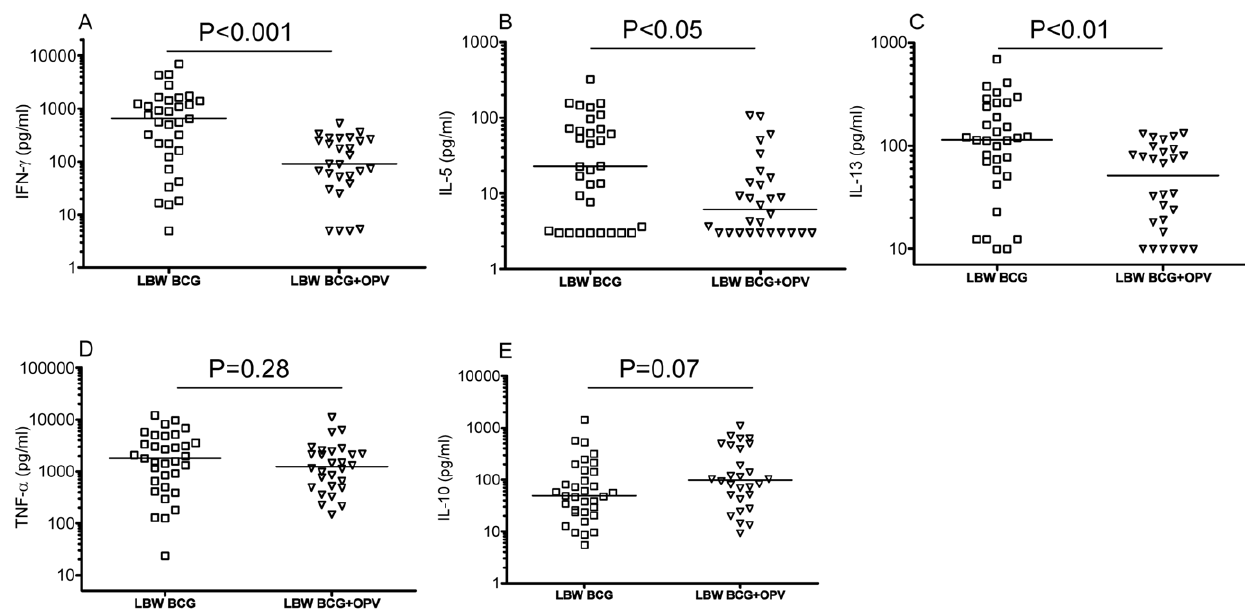
doi:10.1371/journal.pone.0010328.g002